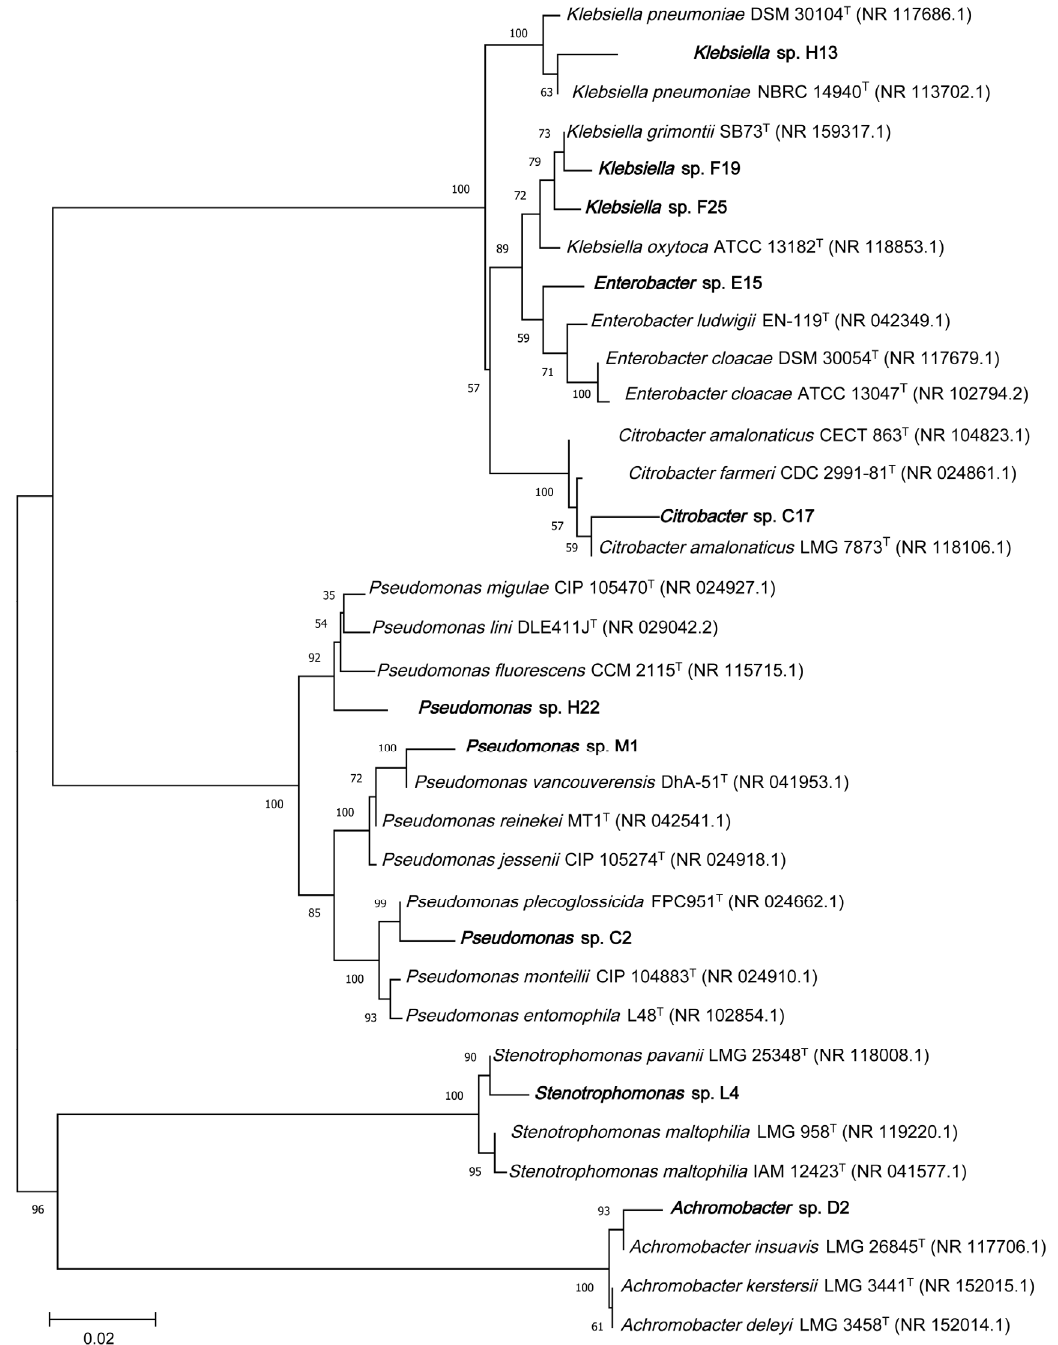
Figure 1. Adjacency phylogenetic tree of the ten selected PGPR strains. Selected strains are shown in bold.